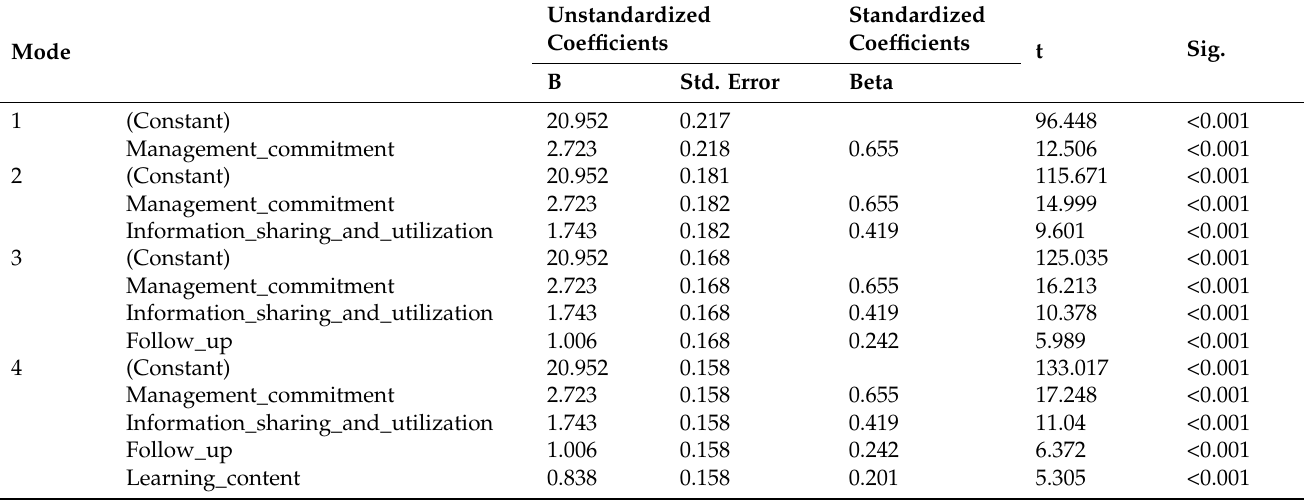
Table 9. Coefficients of the stepwise multiple linear regression